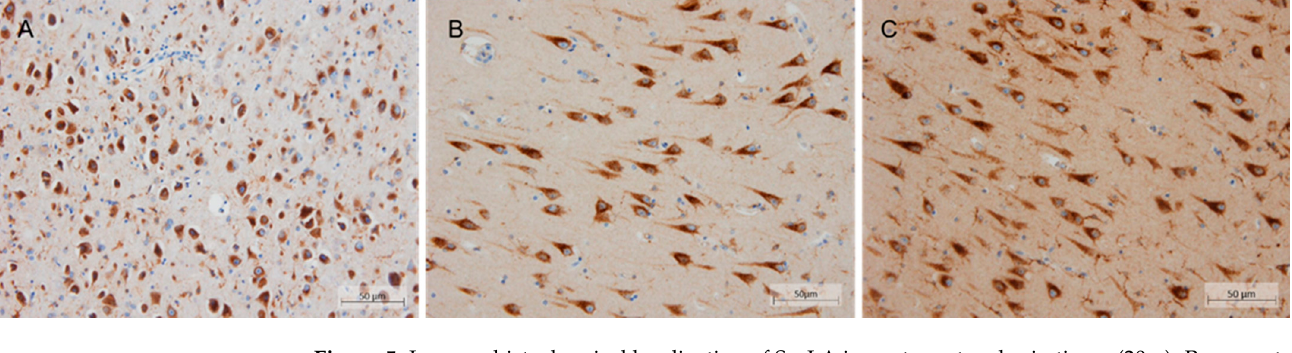
Figure 5. Immunohistochemical localization of SorLA in post-mortem brain tissue (20×). Repre- sentative pictures from ( A ) case 4, ( B ) sporadic AD, and ( C ) control in the CA1 hippocampal region using ab190684 SORL1 antibody. Scalebar: 50 μ m.